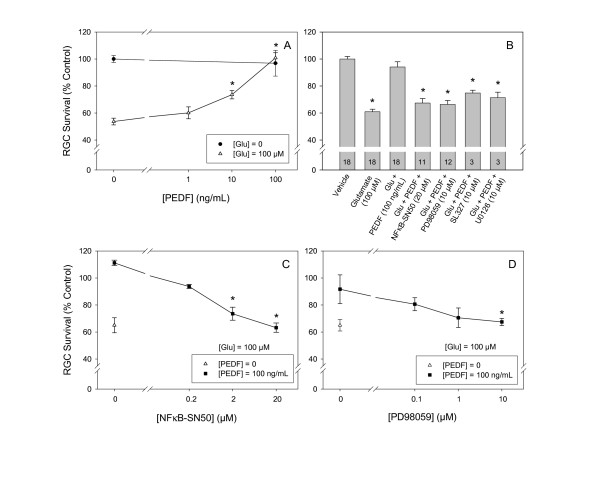
Protective effect of PEDF against glutamate-induced RGC toxicity. (A) Cells were treated with the indicated concentrations of PEDF in the presence or absence of 100 μM of glutamate (n = 6). (B) Effects of various compounds on PEDF protection against excitotoxicity. Numbers on the bars represent sample sizes. (C and D) Concentration-dependent reversal of the PEDF protection by NFκB inhibitor NFκB-SN50 and ERK1/2 inhibitor PD98059, respectively. * represents P < 0.05 vs. the respective control group by One-way ANOVA then Dunnett's test. Glu = glutamate.